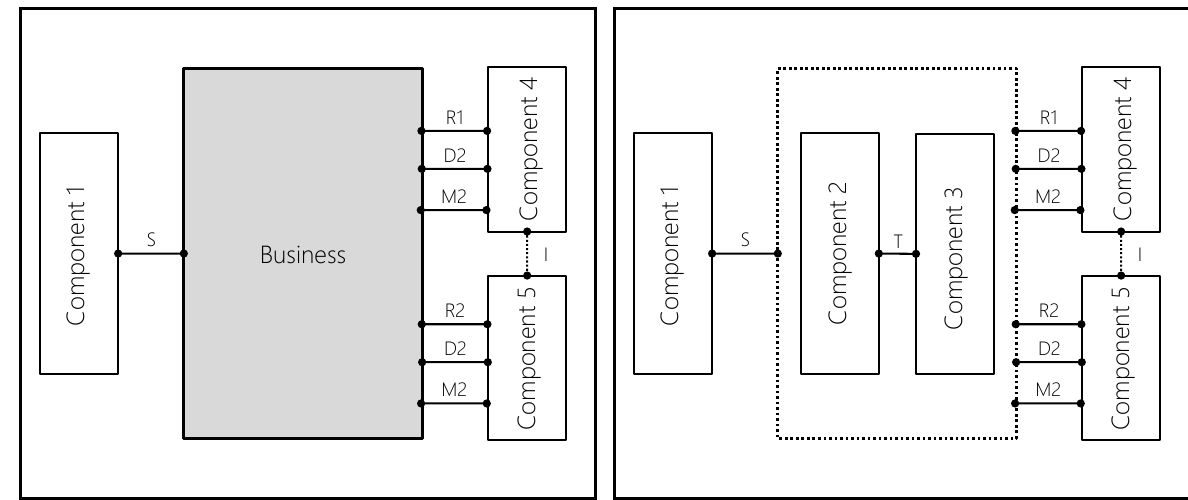
Figure 11. MBM Graphical Notation (Structure Main Component—Internal Components).